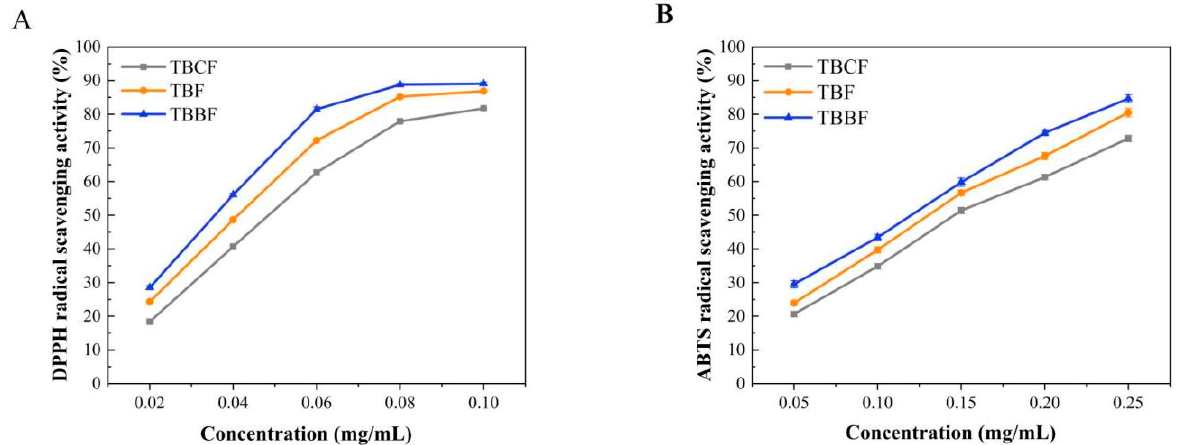
Figure 2. DPPH ( A ) and ABTS ( B ) radical scavenging activities of TBF, TBCF, and TBBF (TBF: Tartary buckwheat flour;